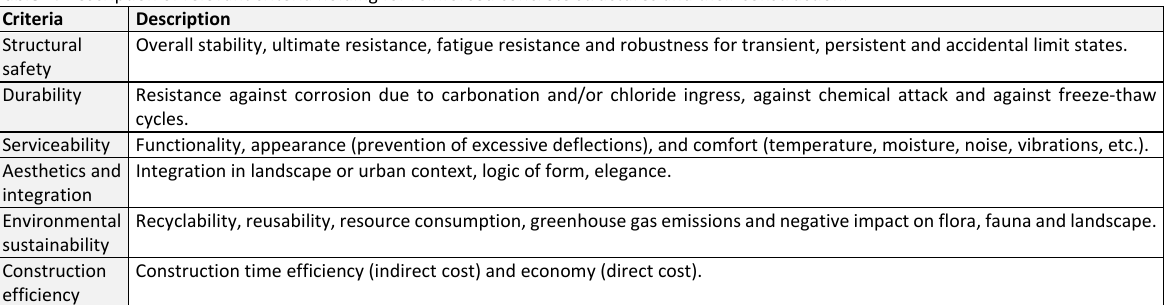
Table 1. Description of relevant criteria holding for reinforced concrete structures and their construction.